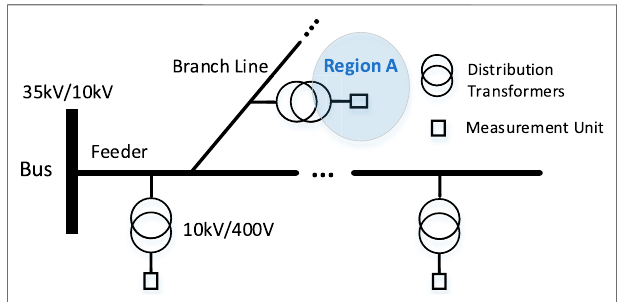
FIGURE2| Topology ofamedium and lowvoltage